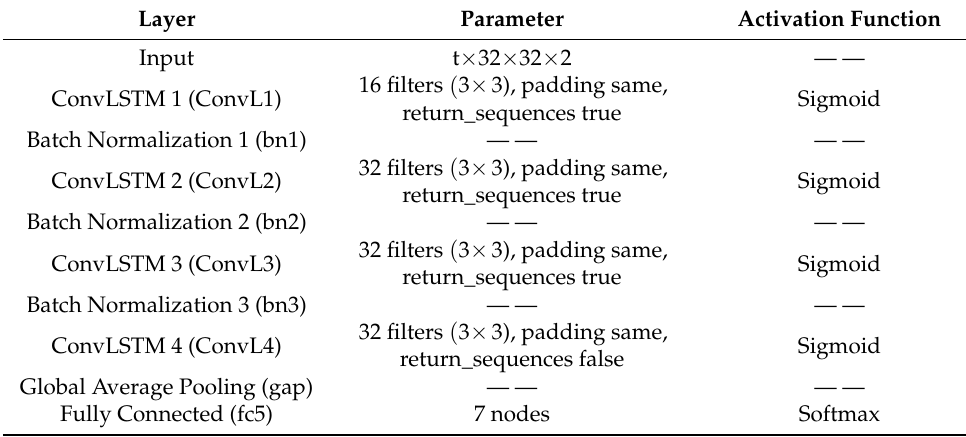
Figure 7. Sea ice classification network architecture based on ConvLSTM. Table 5. Parameters of the sea ice classification network based on ConvLSTM.